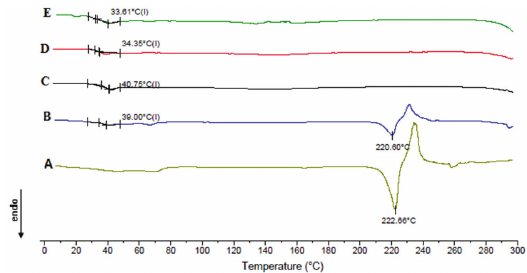
Figure 5. DSC thermograms of (A) pure paclitaxel, (B) a physical mixture of PLDLA + paclitaxel, (C) PLDLA microspheres with paclitaxel, (D) PLDLA microspheres without paclitaxel and (E) PLDLA polymer